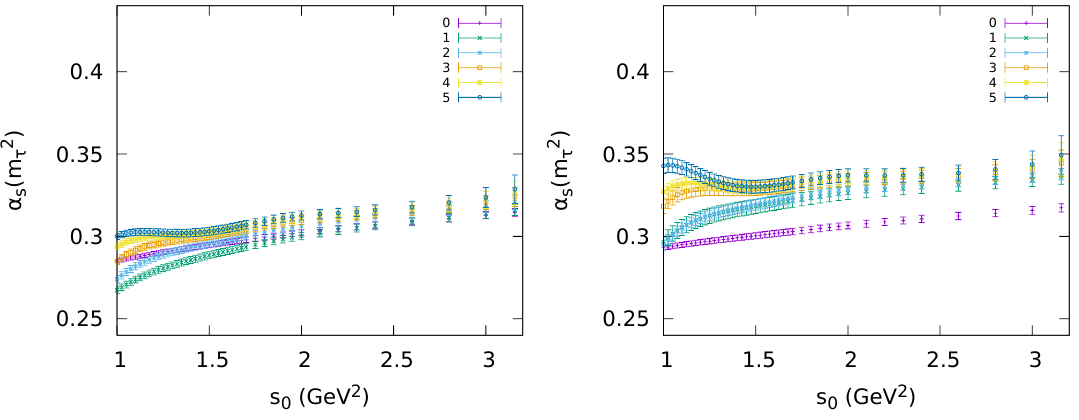
) determinations with FOPT (left) and CIPT (right), extracted from a single Figure 2 . α s ( m 2 τ ( s ) moment, with different weights ω (2 ,m ) ( x ) ( 0 ≤ m ≤ 5 ), at different values of s A ω 0 V + A all non-perturbative effects [40]. Only experimental uncertainties are